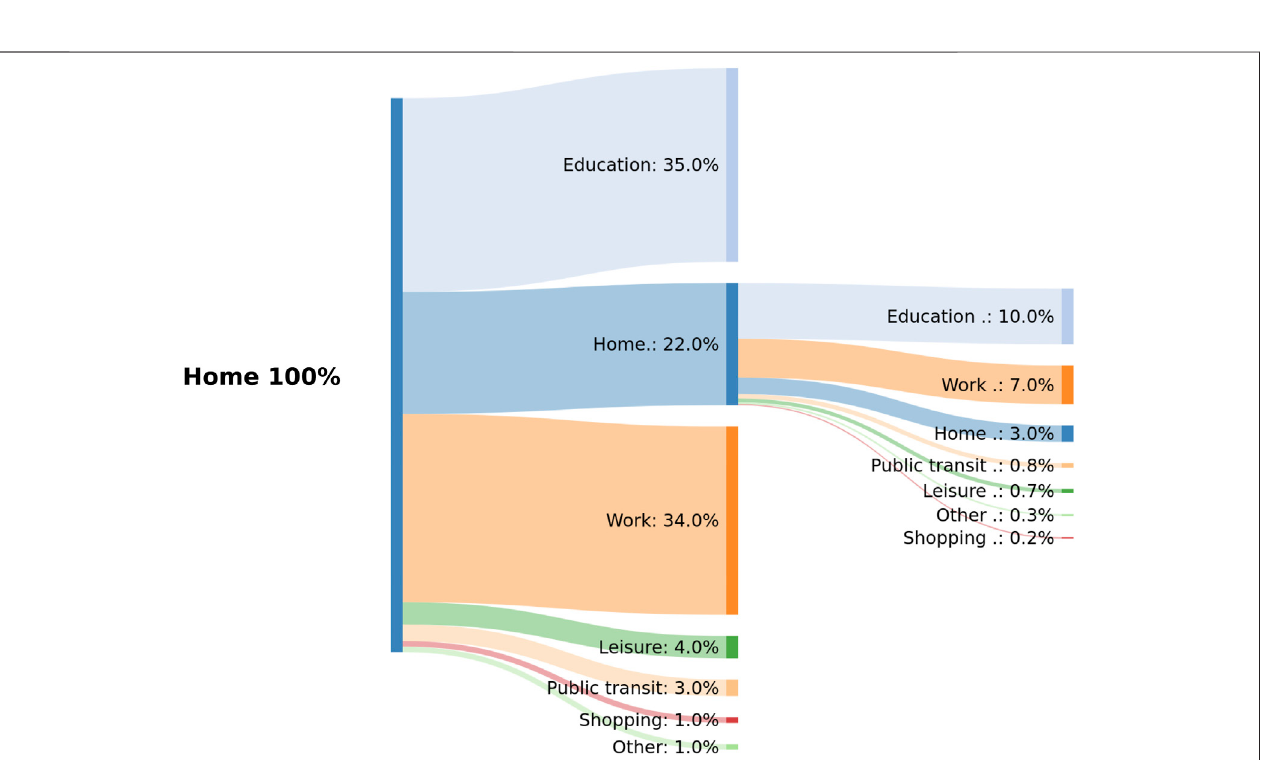
FIGURE 5 | Activities responsible for introducing SARS-CoV-2 into homes traced back to two levels.